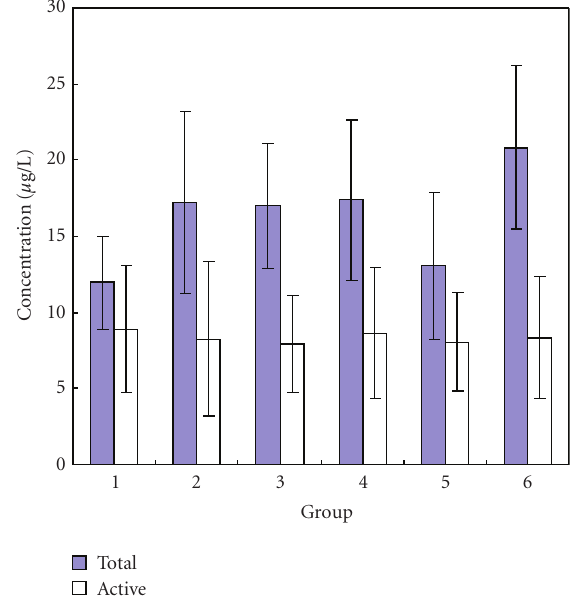
Figure 4: The concentration of total and active TGF- β 1 in di ff erent groups. 1: healthy controls, 2: GCA patients, 3: GCA patients with TSP1 methylation, 4: GCA patients without TSP1 methylation, 5: stage I and II GCA patients, 6: stage III and IV GCA patients.